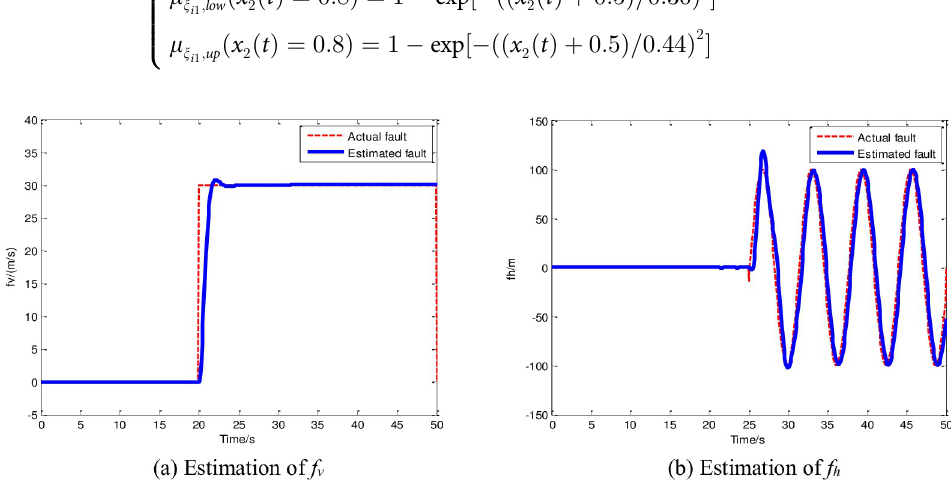
, (b) Estimation of f v h